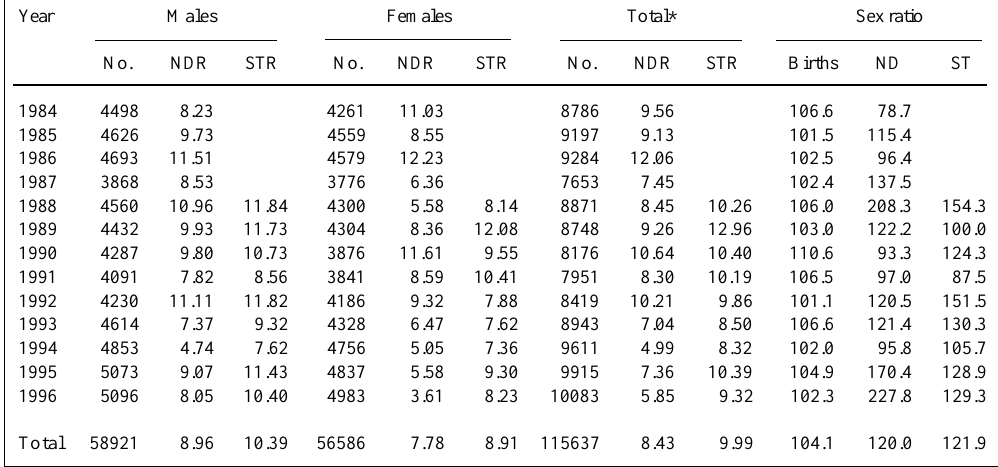
Table I - Early neonatal death rate per 1,000 (NDR) from 1984 to 1996 and stillbirth rate per 1,000 (STR) from 1988 to 1996 among singletons born at the Maternidade de Campinas. The sex ratios (number of males per 100 females) of all